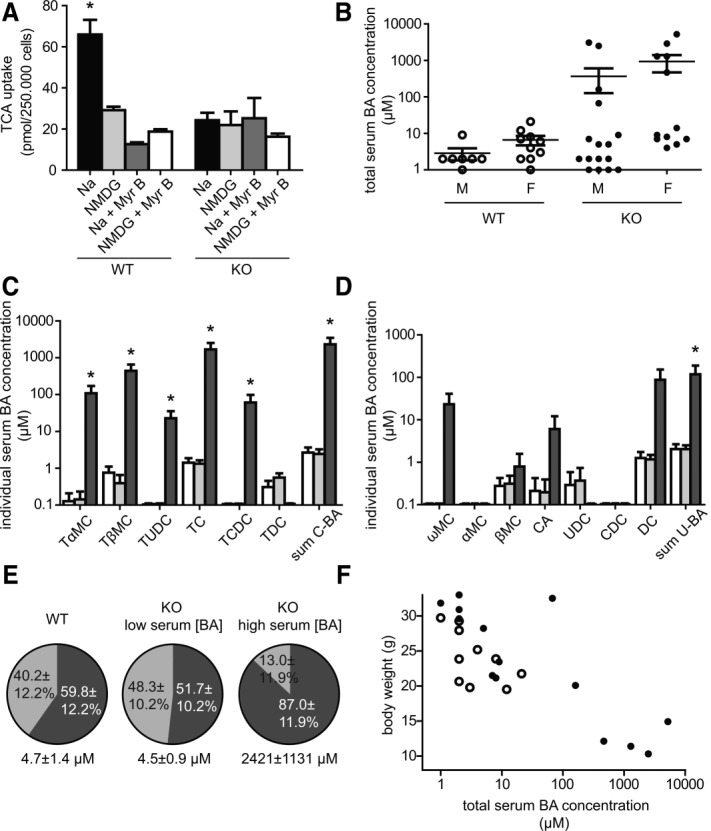
(A) Results of a TCA uptake assay in primary hepatocytes of WT and Slc10a1−/− (KO) mice. Uptake of TCA was determined after preincubation for 30 minutes in sodium-containing buffer (Na, black bar), sodium-free buffer (NMDG, light gray bar), sodium-containing buffer plus 1 μM Myrcludex B (Na + Myr B, dark gray bar), and sodium-free buffer plus 1 μM Myrcludex B (NMDG + Myr B, white bar). Bars represent the mean ± SEM for two independent experiments, each performed in triplicate. *P < 0.05. (B) Total serum BA concentrations in male and female WT and Slc10a1−/− (KO) mice. Data are given as mean ± SEM on a 10log scale for seven to 16 mice in each group, quantified using the total BA assay. Serum composition of (C) conjugated and (D) unconjugated BA species as quantified using high-pressure liquid chromatography. Results for WT (white bars), Slc10a1−/− mice with normal serum BA concentrations (light gray bars), and Slc10a1−/− mice with high serum BA concentrations (dark gray bars) are shown. Conjugated BA (C-BA) concentrations are the sum of tauro-α-muricholic acid, tauro-β-muricholic acid, tauroursodeoxycholic acid, TCA, taurochenodeoxycholic acid, and taurodeoxycholic acid. Unconjugated BA (U-BA) concentrations are the sum of ω-muricholic acid, α-muricholic acid, β-muricholic acid, cholic acid, UDCA, chenodeoxycholic acid, and DCA. Data are given as mean ± SEM on a 10log scale for three to six mice in each group. *P < 0.05 (compared to WT levels). (E) Serum BA composition of WT mice, Slc10a1−/− mice with normal serum BA concentrations, and KO mice high serum BA concentrations. Conjugated BA (dark gray) and unconjugated BA (light gray) species are shown as a percentage of total, as quantified using high-pressure liquid chromatography. (F) Total serum BA levels in relation to body weights of WT (open dots) and KO (black dots) 8-week-old mice (n – 11–14).